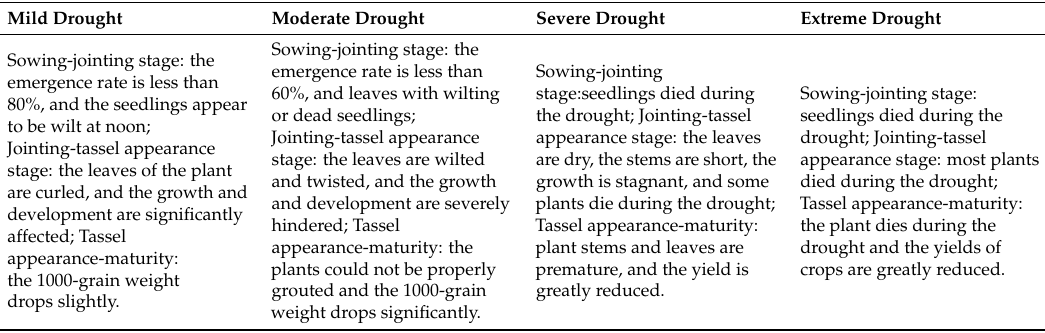
Table 4. The summer maize drought level and the different types of drought conditions in different growth stages.